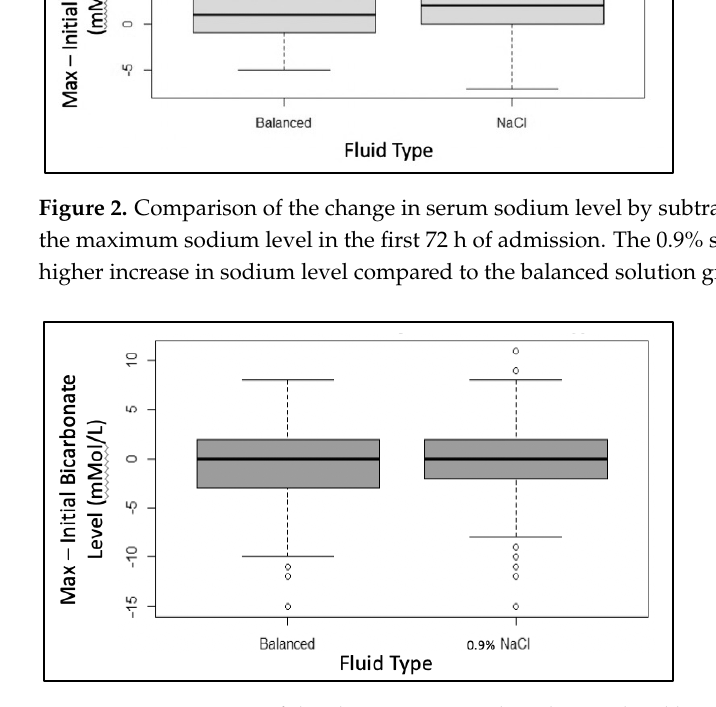
Figure 2. Comparison of the change in serum sodium level by subtracting initial sodium level from the maximum sodium level in the first 72 h of admission. The 0.9% saline group had a significantly higher increase in sodium level compared to the balanced solution group, p < 0.005.